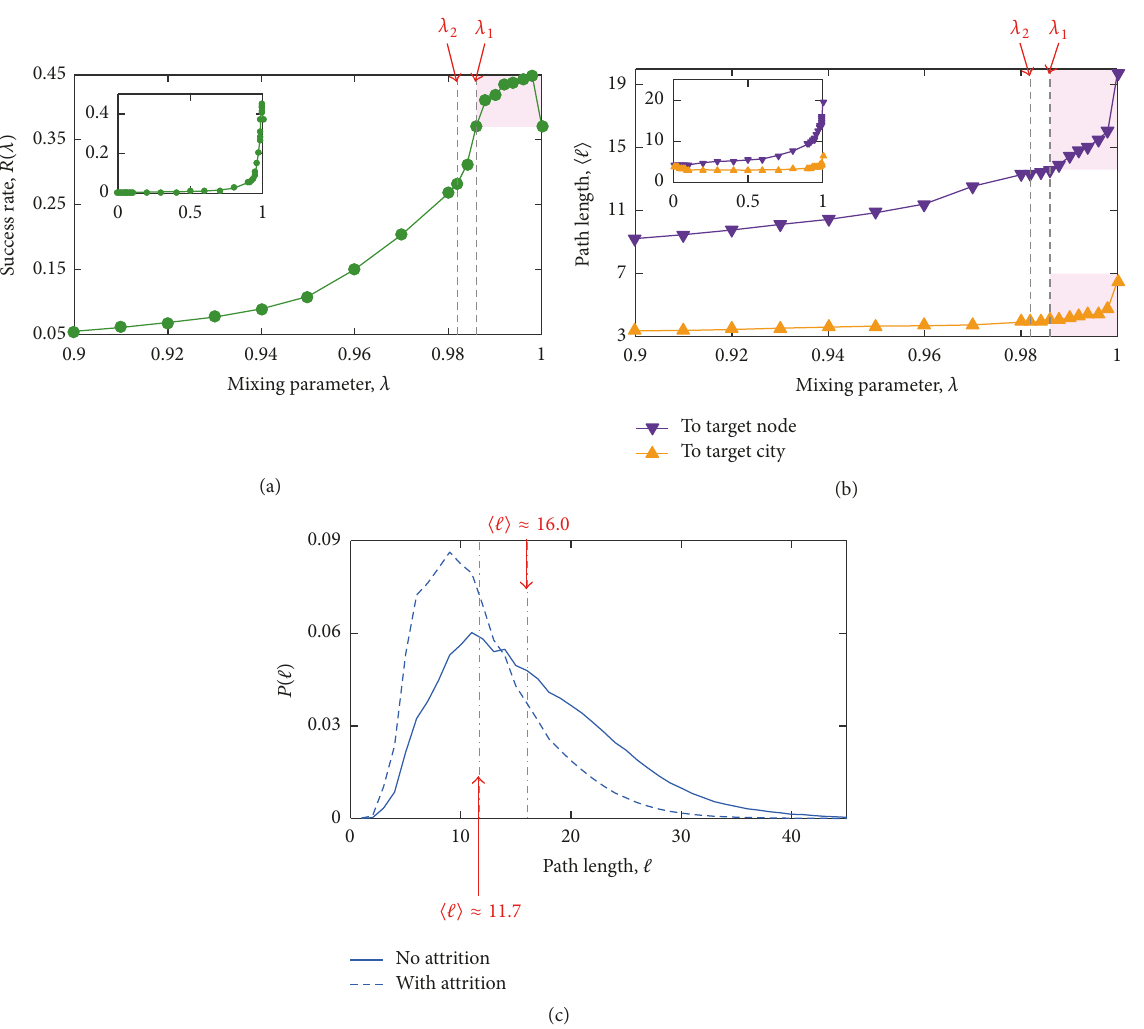
Figure 6: Decentralized paths found with the mixed greedy strategy. (a) Fraction of completed searches 𝑅(𝜆) in the range 0.9 ≤ 𝜆 ≤ 1 . The mixed strategy beats the pure greedy algorithm in the pink-shaded region, 𝜆 1 < 𝜆 < 1 . At 𝜆 = 𝜆 2 the success rate of the mixed strategy matches the 28 % rate reported in Milgram’s work [13]. Inset: 𝑅(𝜆) for the whole range of 0 ≤ 𝜆 ≤ 1 . (b) Average path length from points in City 2 to City 1 (top, purple curve) and average number of links to reach City 1 (bottom, orange curve) in the range 0.9 ≤ 𝜆 ≤ 1 . Inset: Same, for the full range of 0 ≤ 𝜆 ≤ 1 . (c) The effect of incidental attrition: Shown is the distribution of path lengths, 𝑃(ℓ) for 𝜆 = 0.998 (solid line) along with (0.9) ℓ 𝑃(ℓ) , accounting for 0.1 probability of incidental dropout (broken line). The overall success rate reduces from 45 % to 11 % and the conditional average path length ⟨ℓ⟩ decreases from 16 to 11.7. (Both curves are normalized in the figure, to highlight the change in shape that results from incidental